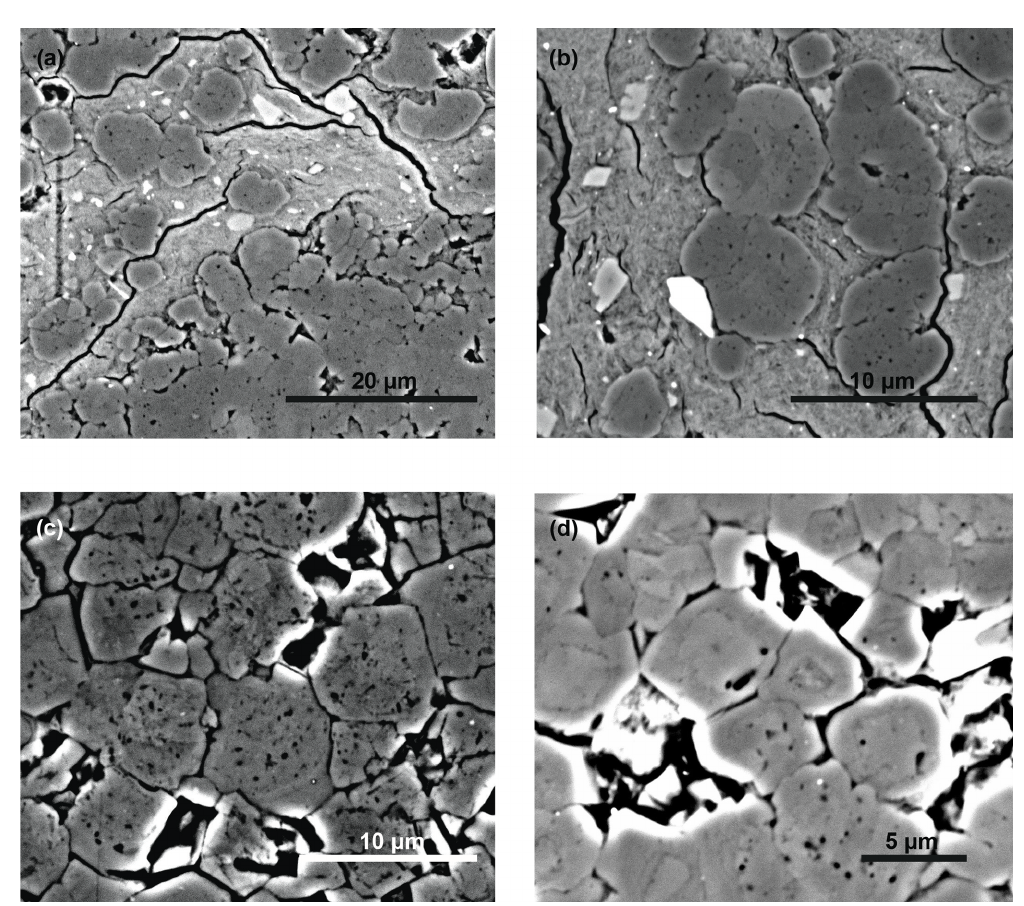
Figure 6. SEM images of dolomites in backscatter mode showing different types of crystal shape: (a) spheroidal growth of dolomite (darker areas) in clay layers (brighter areas; sample TZ14-9d; 95m); (b) close-up of (a) ; (c, d) dolomite crystals showing a porous interior and homogeneous syntaxial cement rims ( c : sample TZ14-12; 90m; d : sample TZ14-9d; 95m).